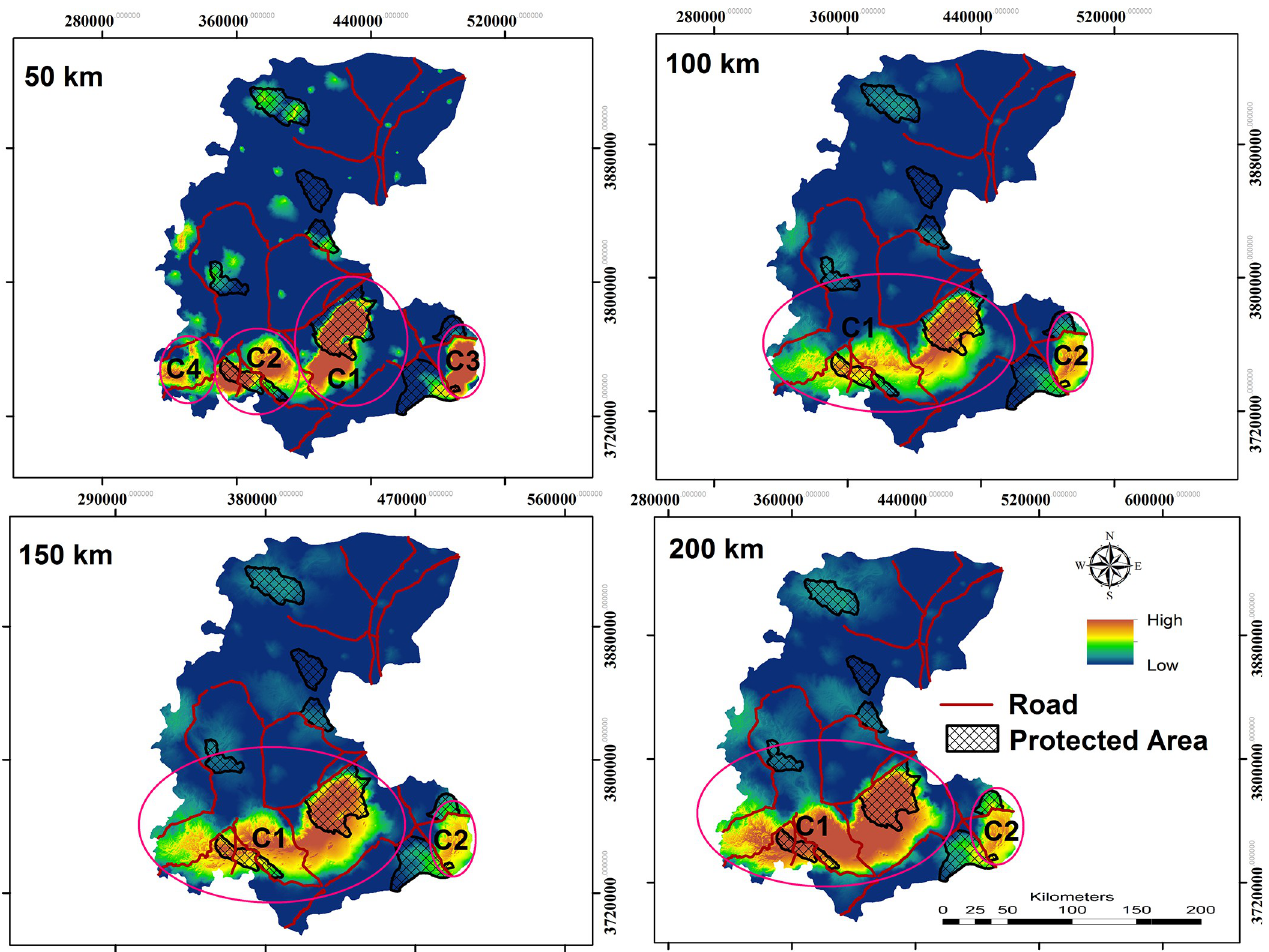
Fig 3. Grey wolf core areas at dispersal ability 50, 100, 150 and 200 km respectively and network of CAs and roads. Republished from [http://www.frw.ir] under a CC BY license, with permission from [Forest, Range, Watershed Management Organization of Markazi province (IFRWO)], original copyright